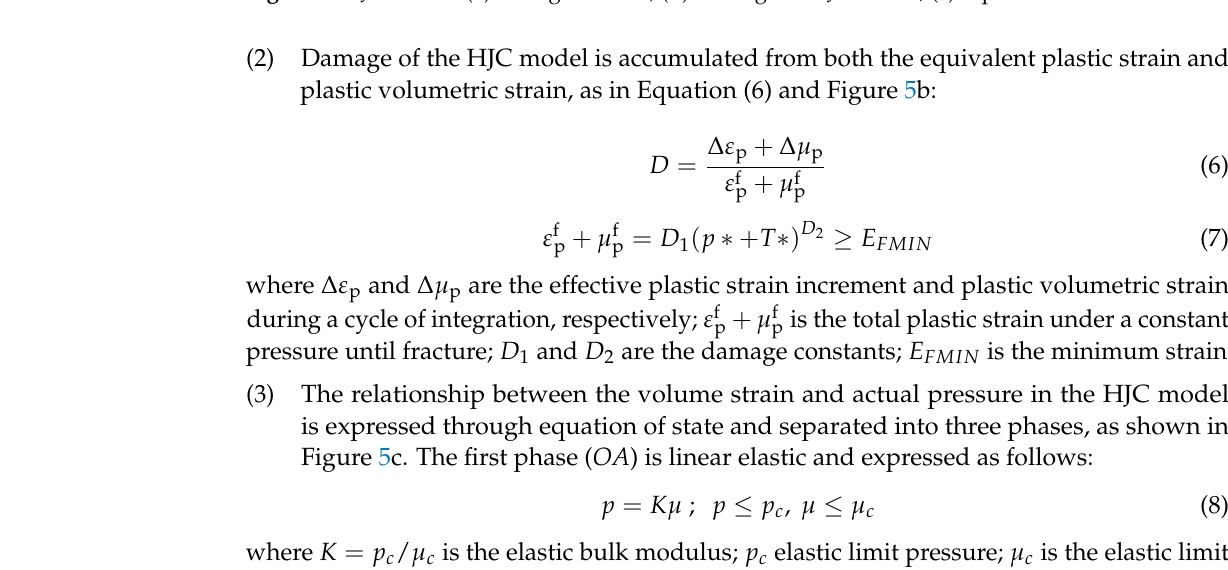
where K = p c / µ c is the elastic bulk modulus; p c elastic limit pressure; µ c is the elastic limit volumetric strain. In the second phase (AB), the void inside the material is gradually compressed and the plastic volumetric strain appears.